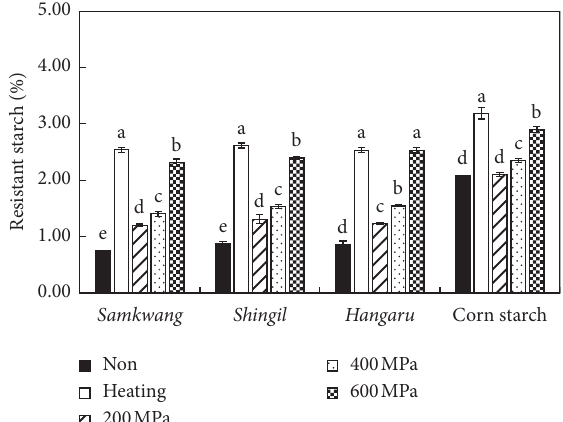
Figure 5: Resistant starch content of different rice flours by treatment methods. Values are mean ± SD. n � 3. Different small letters in the same items indicate a significant difference by Duncan’s range test ( p < 0 . 05) according to the treated method.